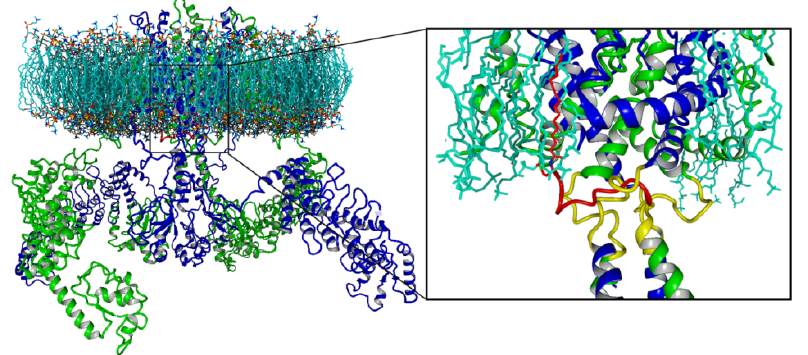
Figure 4. Proposed binding model of Transducins. Full model of TRPV1 channel inserted in a lipid bilayer [203]. The big N - and C -terminus protrude to the cytosolic space. The TRPV1 channel tetramer was represented in ribbons and subunits were colored alternating green and blue. The box represents an ampliation of the cytosolic mouth of the channel, where fragments S6 of transmembrane domain, and the contiguous C -terminus of each subunit converge. The most active TRPducin (represented in red) was derived from the linker connecting the S6 and proximal C -terminus (in yellow). The palmytoilated TRPducin might reach the cytosolic space, and interfere with tetramerization and normal activity of TRPV1 channel, as depicted in the